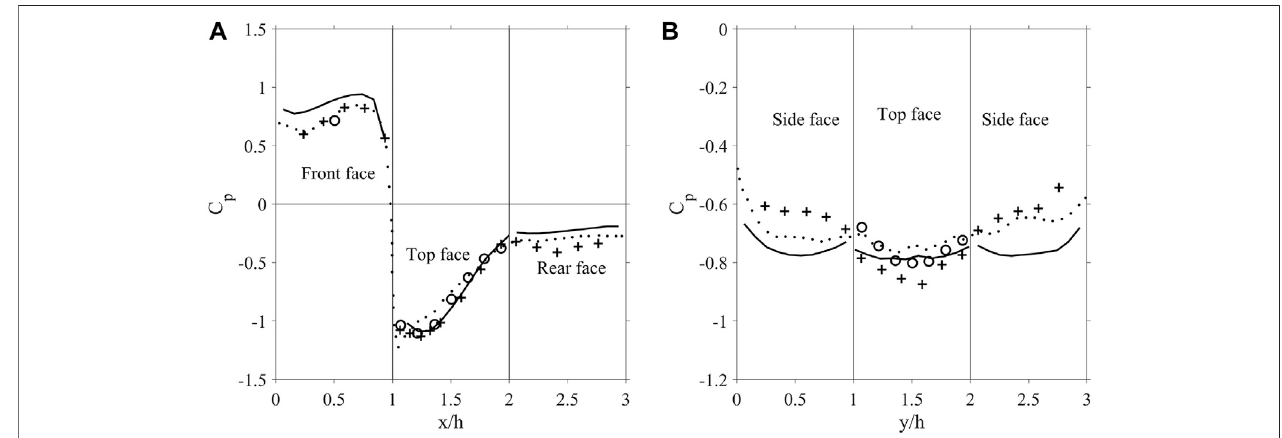
FIGURE4| Pressurecoef fi cientonthesurfaceofthecubeinthe fl owvalidationstudy; (A) theaxialcenterlinewhere y / h (cid:3) 0;and (B) thetransversecentrelinewhere x / h (cid:3) 0 . 5 in the experiments of Lim et al. (2009) ( + ) and Richards et al. (2001) (+), the simulations of Lim et al. (2009) (dotted line) and the present computational study (solid line).